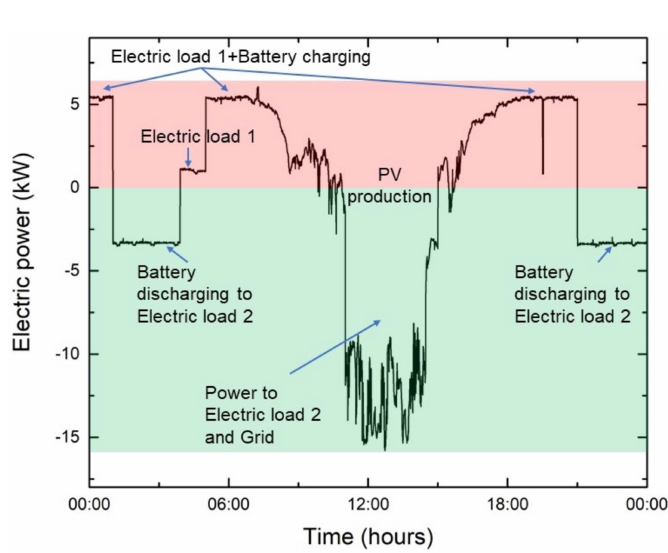
Figure 7. Unified electric power production and consumption over 24 h (1 March